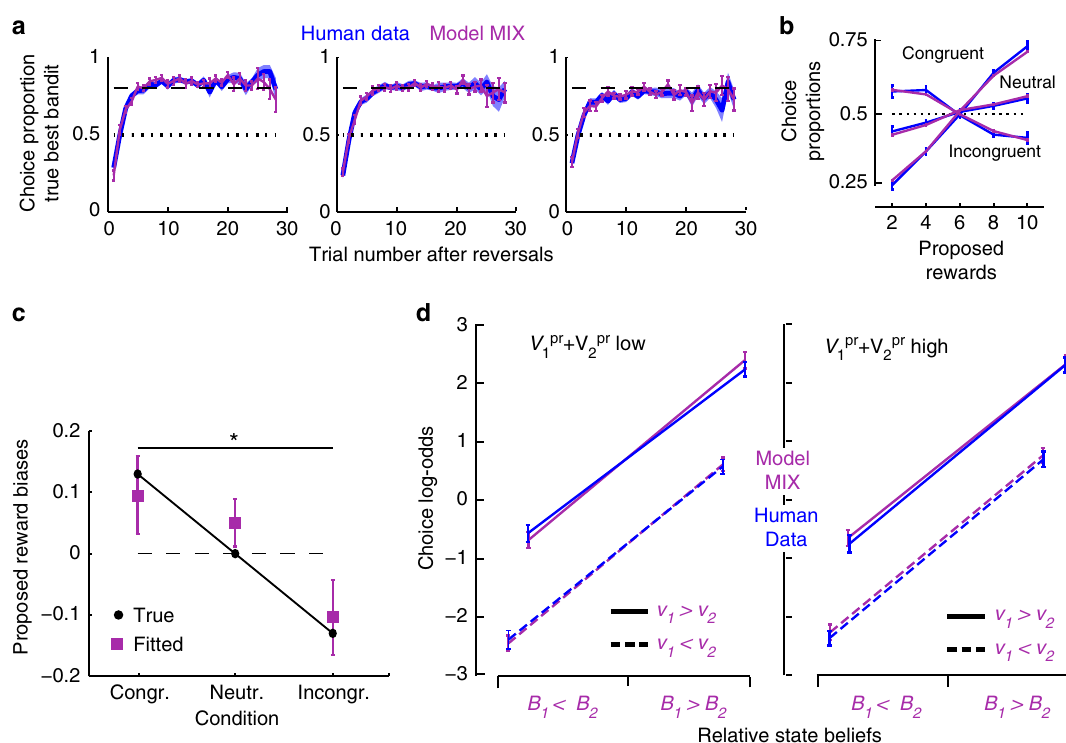
Fig. 3 Model MIX fi t to human performances. a Proportions of choosing true best bandits (maximising reward frequencies x proposed rewards) following reversals. b Proportions of choosing proposed rewards. In a and b , mean proportions over individuals (±s.e.m.) are shown in the congruent, neutral and incongruent condition for participants (blue), and fi tted model MIX (purple) simulations. See Supplementary Fig. 1 for model RL fi t. c Parameter estimates of proposed rewards biases in the congruent, neutral and incongruent conditions in model MIX fi tting human choices, * p <0.05 (T-tests). These estimates are similar to true values (±0.13, see Fig. 1b) indicating that according to model MIX, participants adequately inferred state beliefs. d Factorial analysis of choice log- odds over trials sorted according to inferred state beliefs ( B 1 > B 2 vs. B 1 < B 2 ), normalised utilities ( v 1 > v 2 vs. v 1 < v 2 ) and total proposed rewards ( V pr median split: left vs. right panel) for model MIX simulations (purple) and human data (blue). Both model MIX and human data exhibited main effects of beliefs and utilities (all F s(1,21)>116.9, p s<0.00001), no main effects of total proposed rewards (both F s(1,21)<1.2, p s>0.47 and no interactions between these factors (all F s(1,21)<3.3, p s>0.14). See Supplementary Table 2 for model best- fi tting parameters. Error bars are s.e.m. over participants ( N =